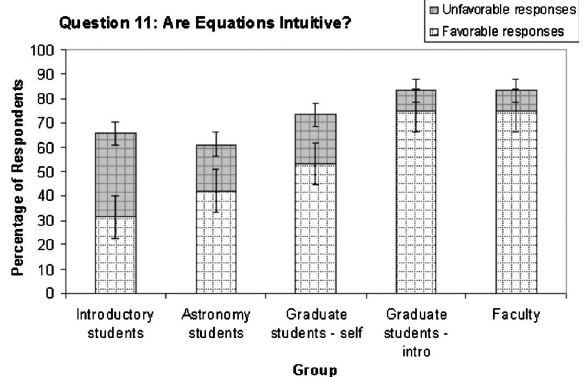
FIG. 2. Histogram showing favorable (cid:1) agree (cid:2) and unfavorable (cid:1) disagree (cid:2) responses for survey question (cid:1) 6 (cid:2) . The histogram shows that faculty were always aware of when they were wrong in prob- lem solving but other respondents were less certain. Only about 50% of graduate students could tell that their answers were wrong in graduate-level problem solving. Graduate students-self and Graduate Students-intro refer to Graduate students’ response for graduate-level problem solving and introductory-level problem solving, respectively.